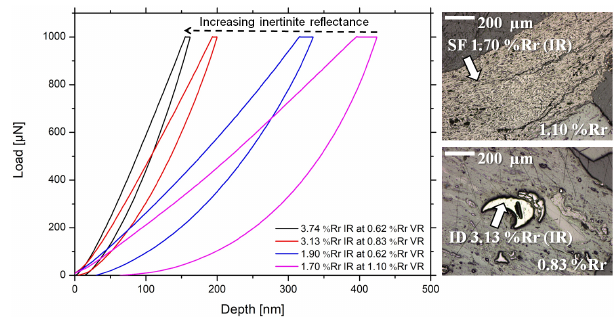
Figure 7. Averaged load-displacement curves for inertinites at different coal ranks. The deformation behaviour changes rapidly with increasing IR, as indicated by the dashed arrow. Insets show different investigated inertinite sub-macerals (SF = semifusinite; ID =